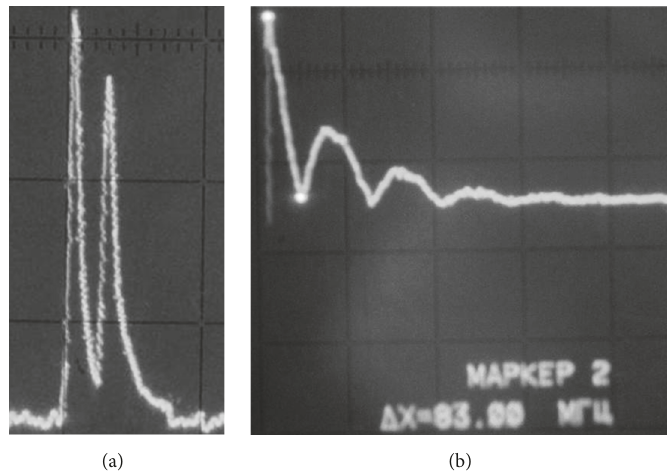
Figure 15: The waveform (a) and the spectrum (b) of the signal at the far end of a structure without a wire break.